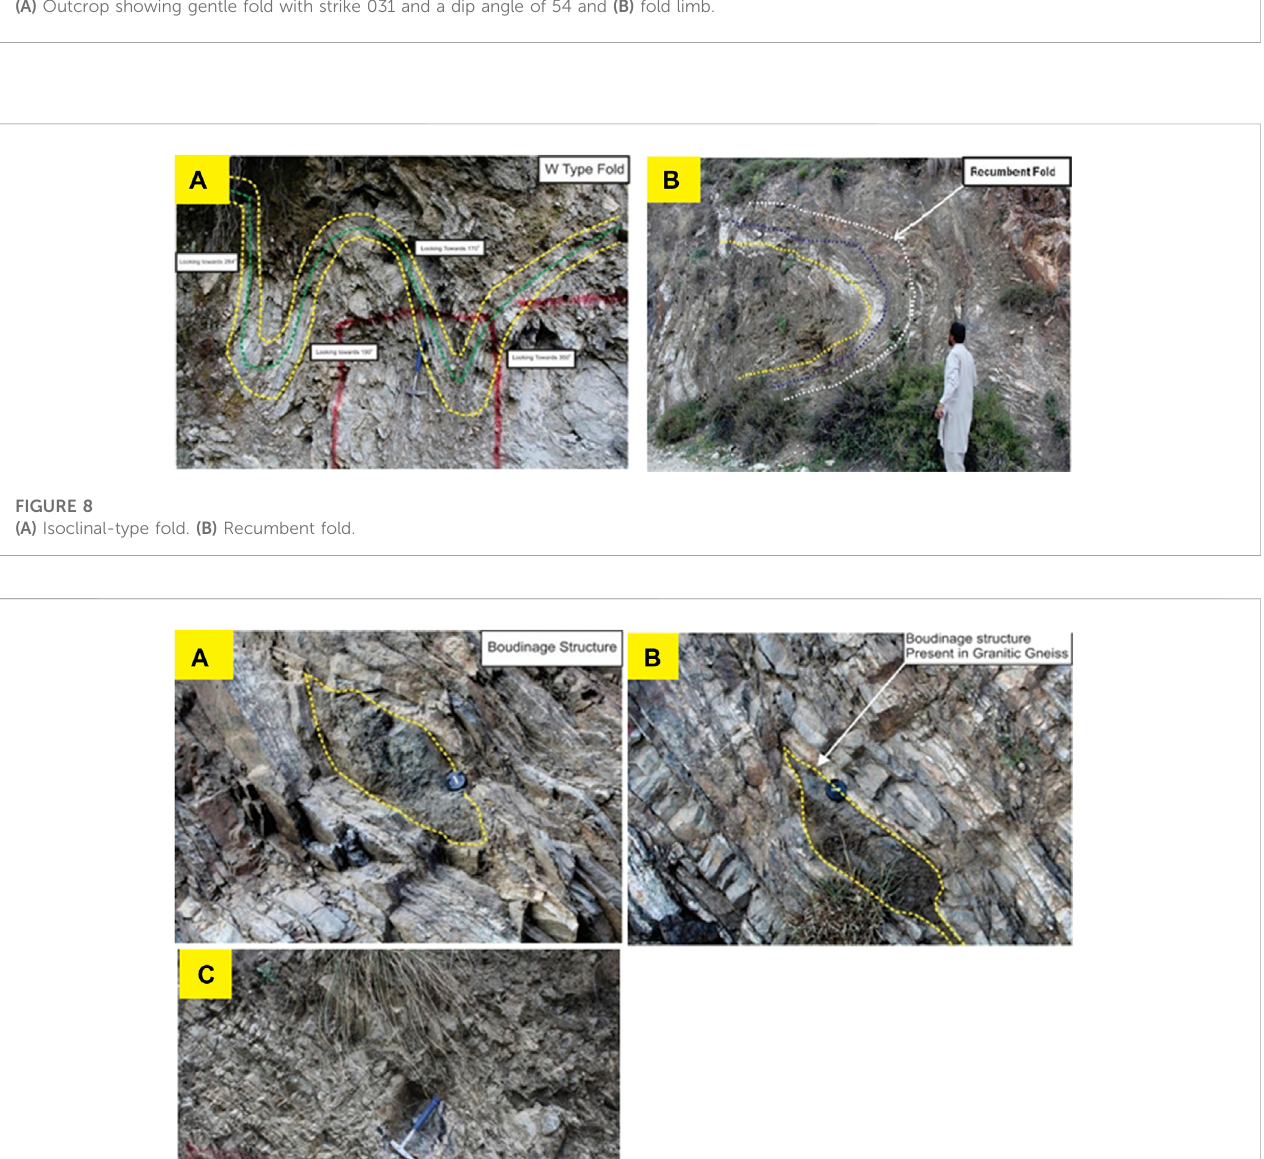
Frontiers in Earth